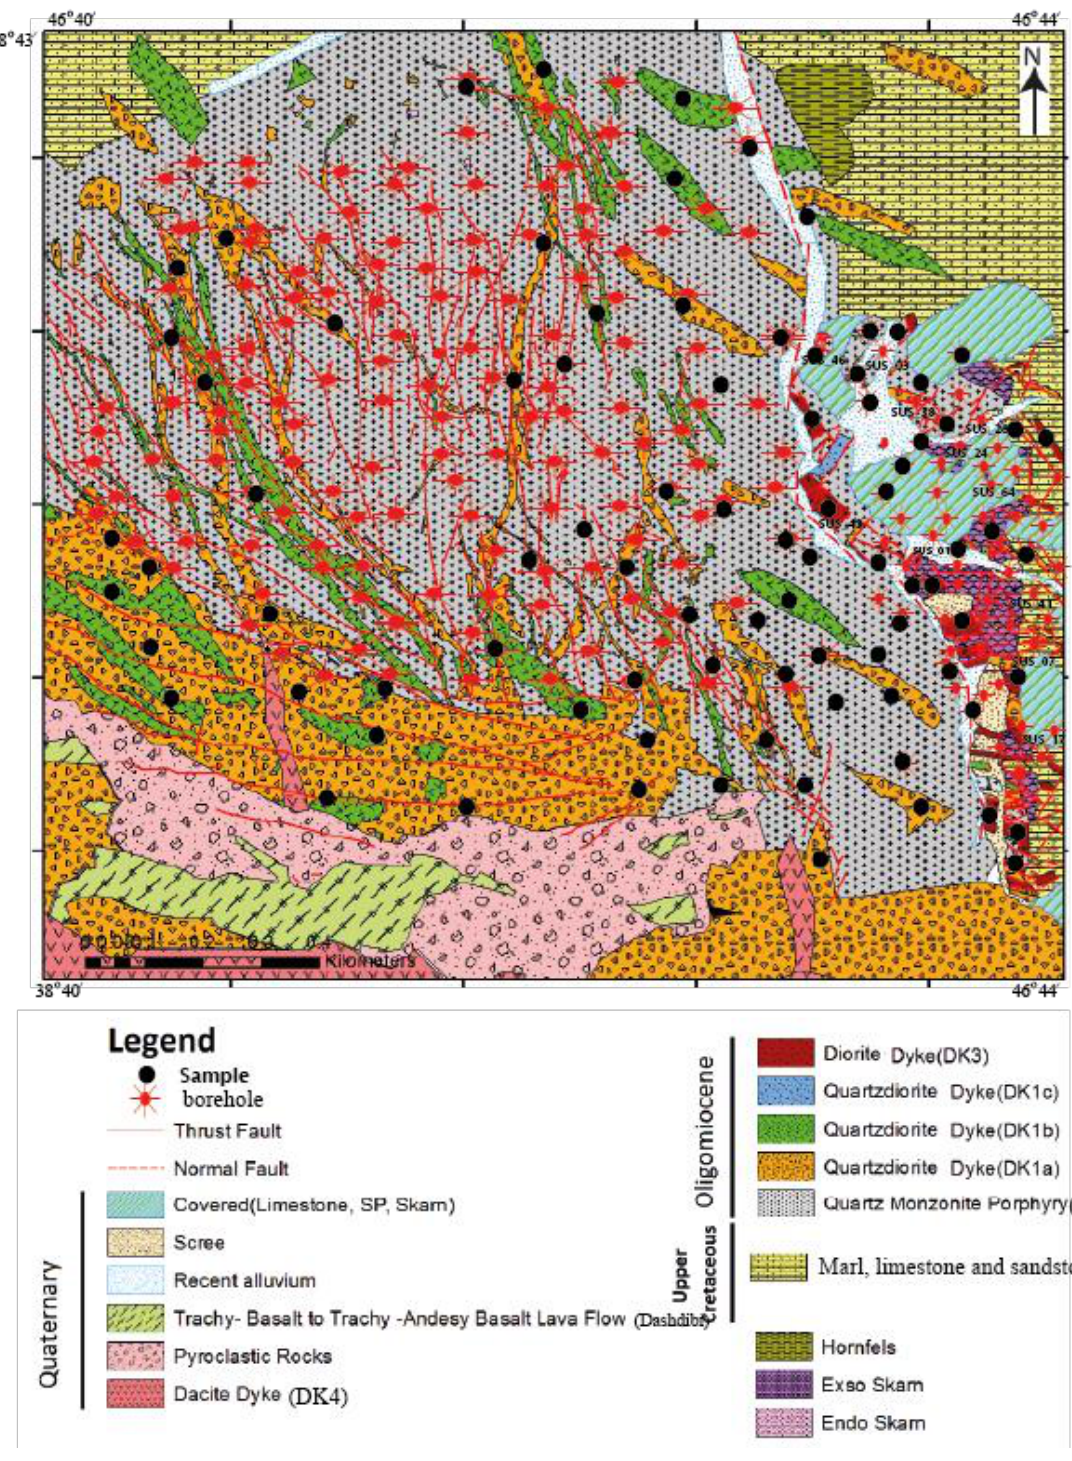
Figure 2. Geological map of the Sungun Copper Mine [28].